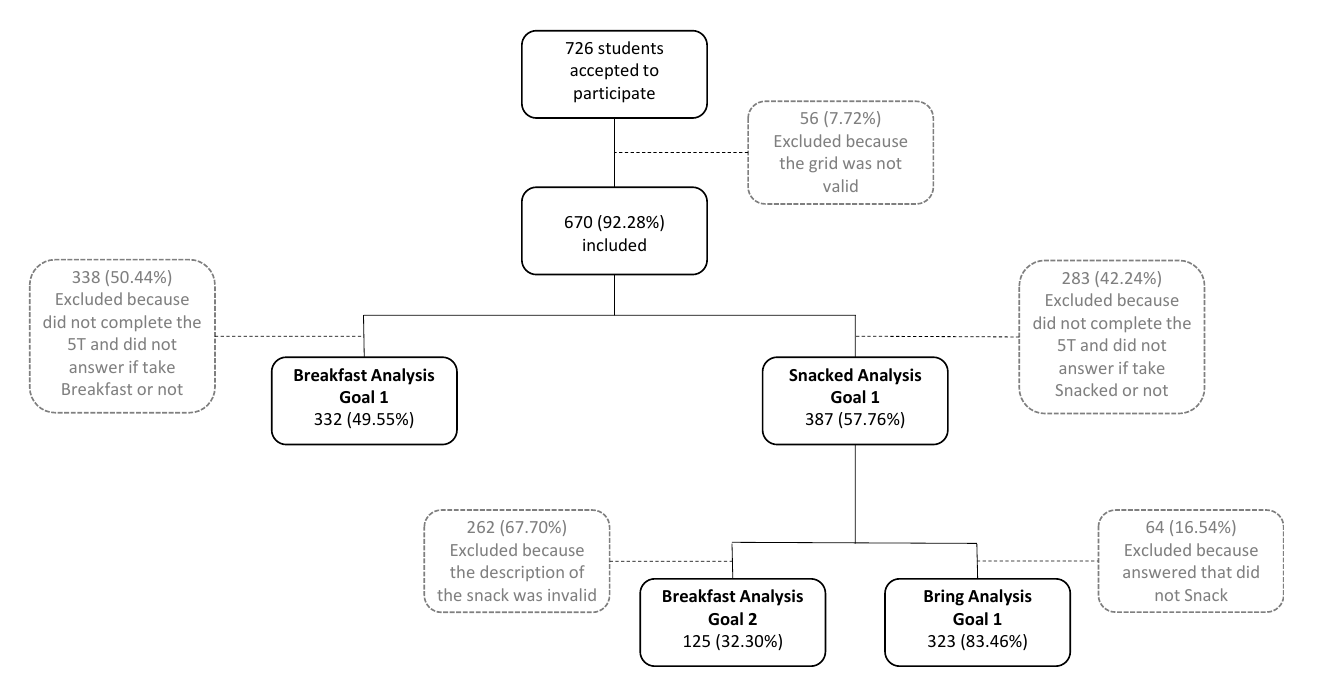
Figure 1. Flowchart of the participants’ inclusion/exclusion process for each study goal: breakfast consumption, snacking, and bring analysis (i.e., where the snack was acquired) for the first goal; qualitative analysis for the second goal (black boxes refer to the participants included in the study, and the grey ones refer to participants excluded from the study).